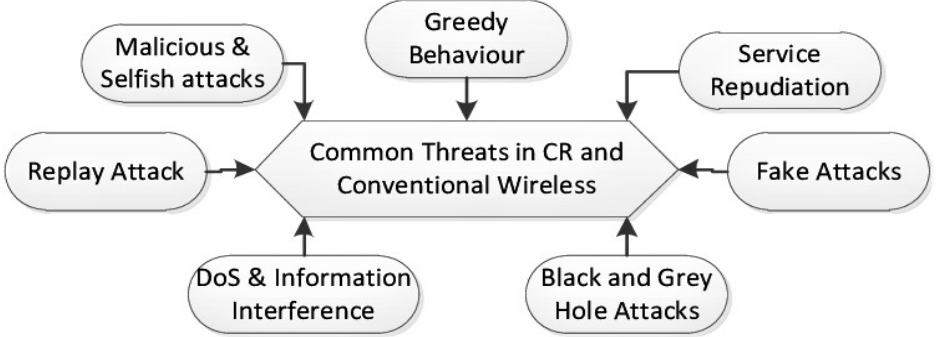
Figure 4. Common security threats in wireless network.